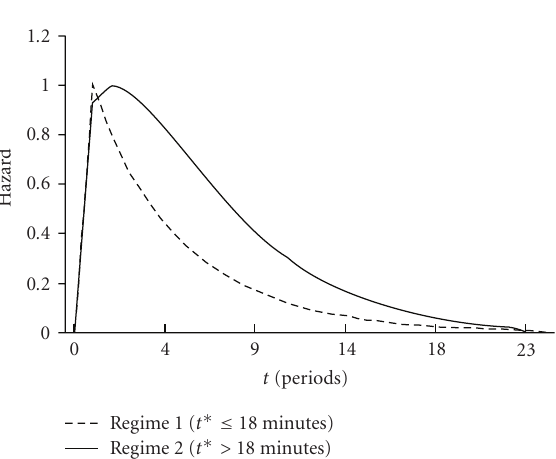
Figure 8: Hazard function for each of the two regimes of T-WACD (cid:3) 1 , 1 (cid:4)